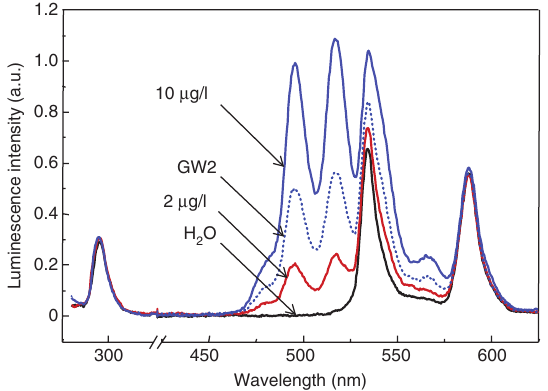
Figure 7 Raman bands of water and the U(VI) luminescence spectra for pure water, reference solutions (uranium concentration of 2 and 10 μ g/l), and the groundwater sample